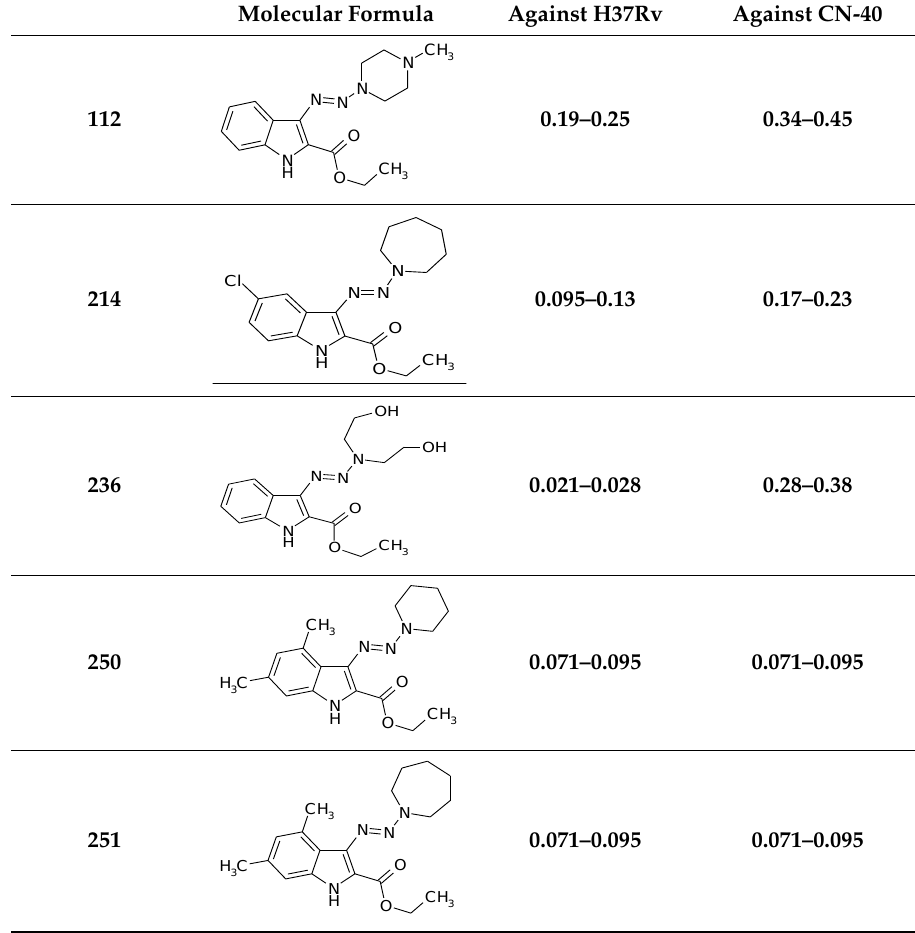
Table 1. Anti-mycobacterial activity of new of 3-triazenoindoles (concentration range, µg/mL) *, **. Molecular Formula Against H37Rv